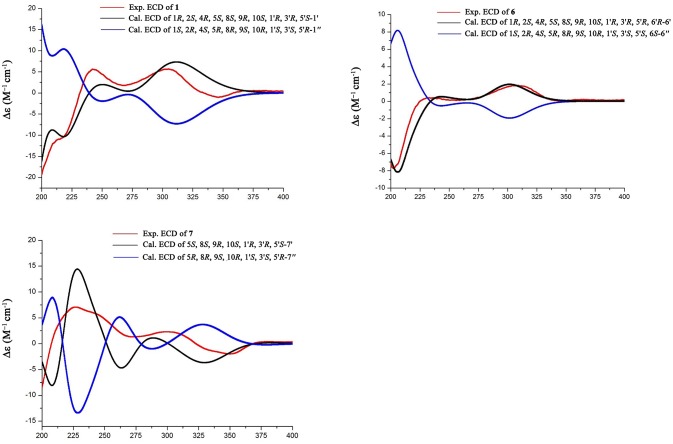
Experimental and calculated ECD of 1, 6, and 7.